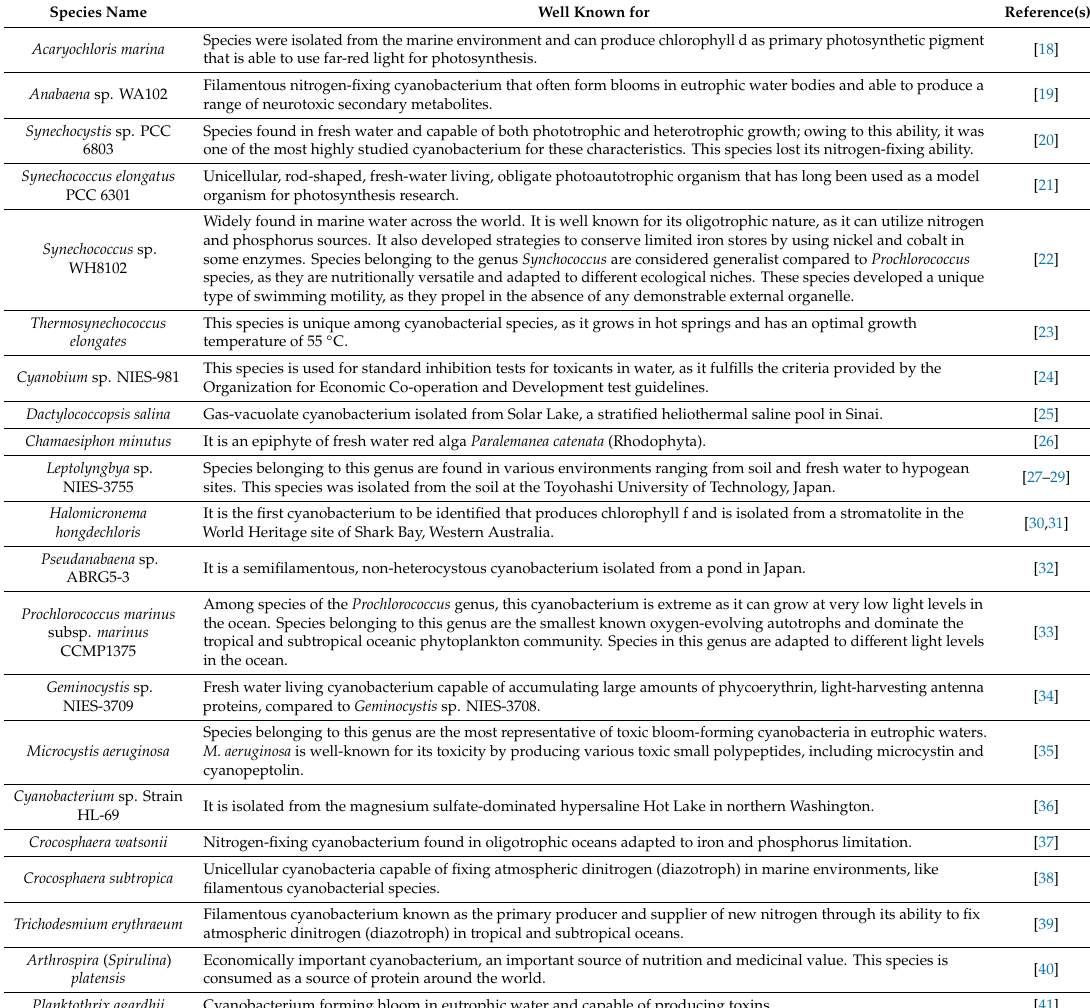
Table 1. Some of the cyanobacterial species well-known